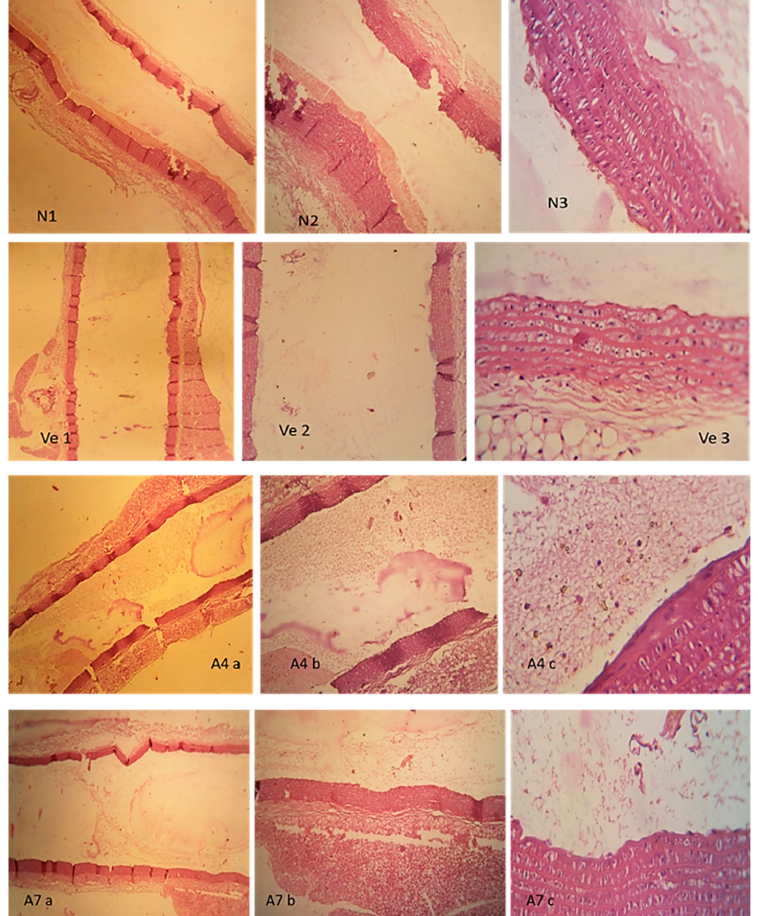
Figure 8. Histopathological slides of aorta obtained during comparative analysis of control group (N), where uniform intact layer of endothelial lining; negative control group (-Ve) where endothelial cell layer is normal. In tablet (A4) formulation group given to animal the intact endothelial lining with uniform tunical media and adventia, and in marketed drug (A7) group intact endothelial lining with uniform tunical media and adventia. However, in all groups no sign of atherosclerosis or necrosis were seen.